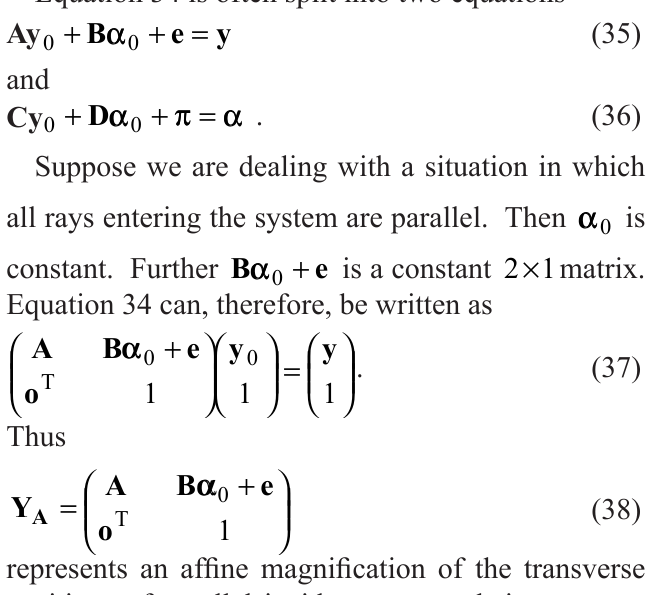
(Equation 26) 4 (Equation 29) 5 (Equation 6 (Equation 7 to 5